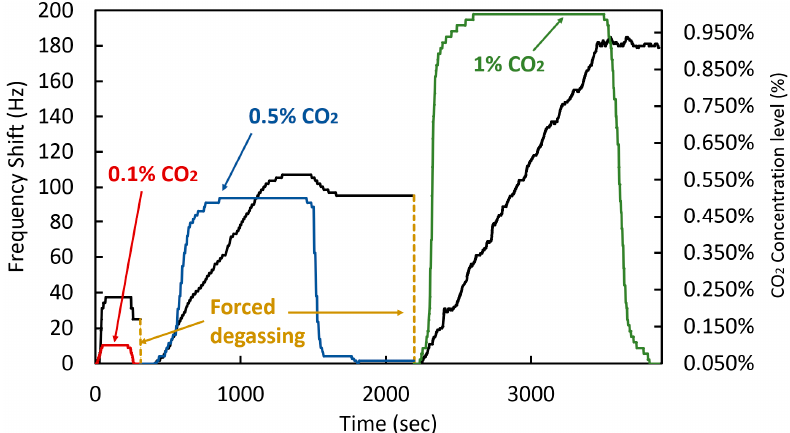
Figure 12. Frequency shift of the quartz crystal with linear PEI with rGO in response to different CO 2 concentration.